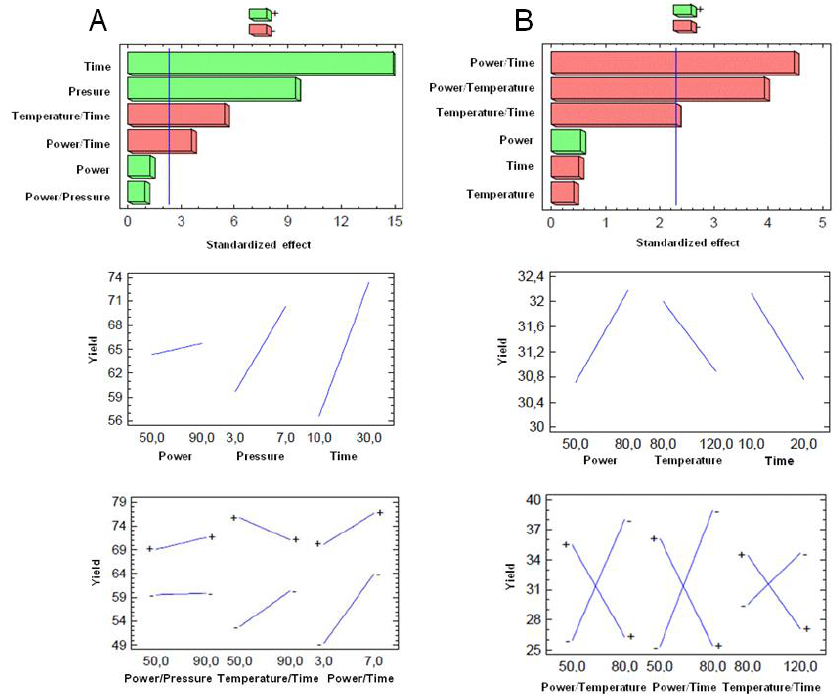
Figure 1. Standardised ( p = 95%) main effects Pareto charts for the Plackett–Burman desing for the different variables studied and graphs of main effects in AS101 yields by Method A ( A ) and by Method B ( B ).